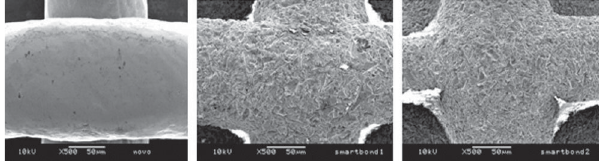
Fig. 4 - Scanning electron micrographs of a bracket base (A) after first (B) and second recycling (C) with aluminum oxide blasting.